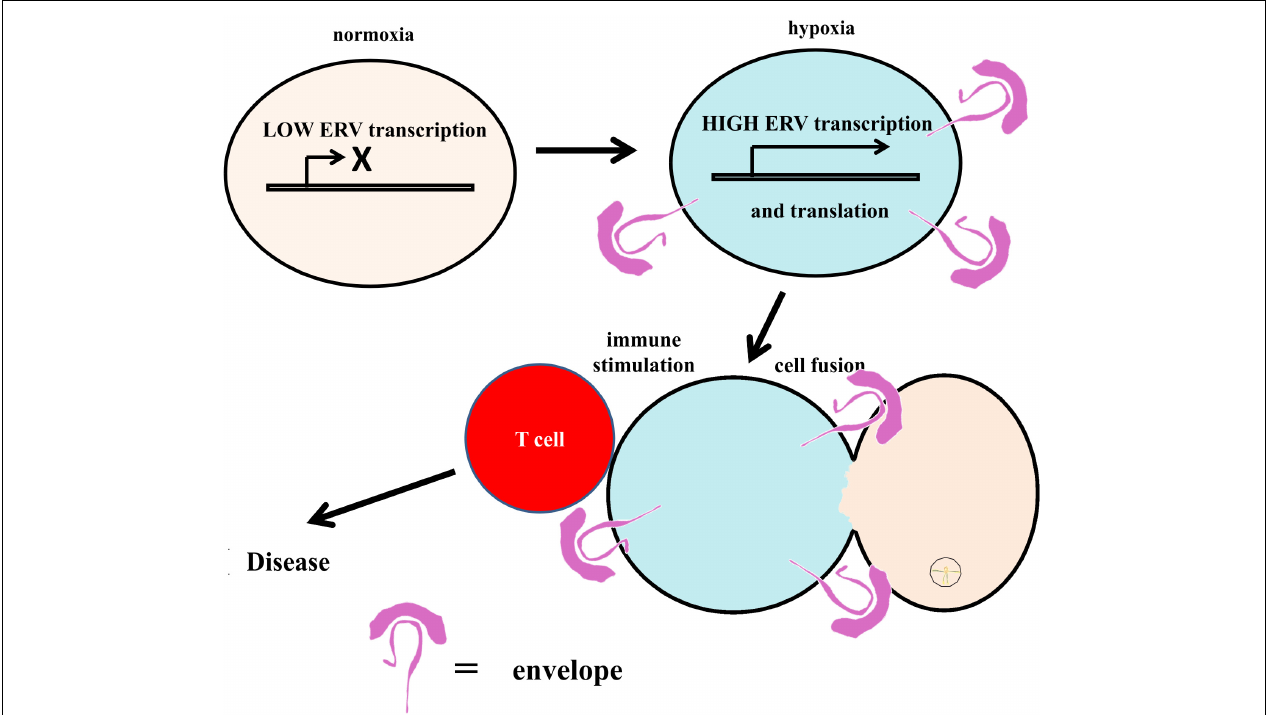
FIGURE 1 | A working model for ERV reactivation. ERVs constitute an integral part of our genome. Under normal conditions, expression of ERVs is switched off epigenetically. Triggered by diverse factors like hypoxia, reactivation of ERV expression can be induced. ERV-encoded proteins can act as immunostimulatory superantigens or induce cytopathic effects, e.g., cell